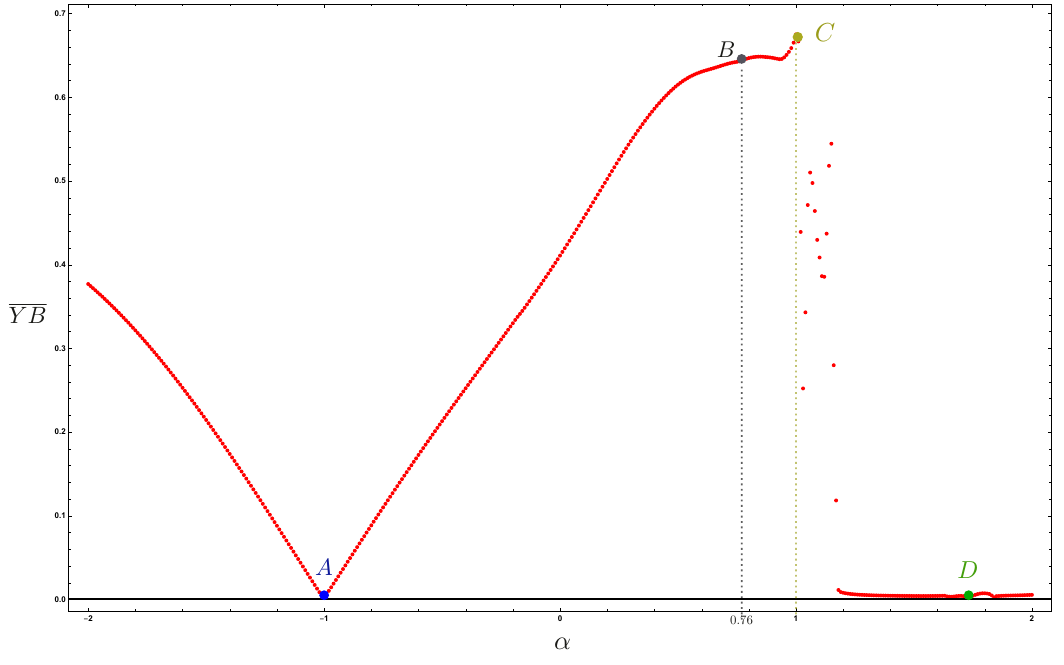
Figure 10. Because of Z 2 symmetry, some Yang-Baxter equations are automatically satis(cid:12)ed. Y B is an average over the non-trivial Yang-Baxter equations, with external rapidities at physical values. The qualitative features of the plot do not depend on averaging over the equations nor on the values of the external rapidities, taken here to be (cid:18) 1 = 1 = 2, (cid:18) 2 = 0, (cid:18) 3 = 1 = 3. Once again, (cid:0) A: Potts massive (cid:12)eld theory, B: maximum coupling g 112 , C : beginning of elliptic deformation line, D : supersymmetric